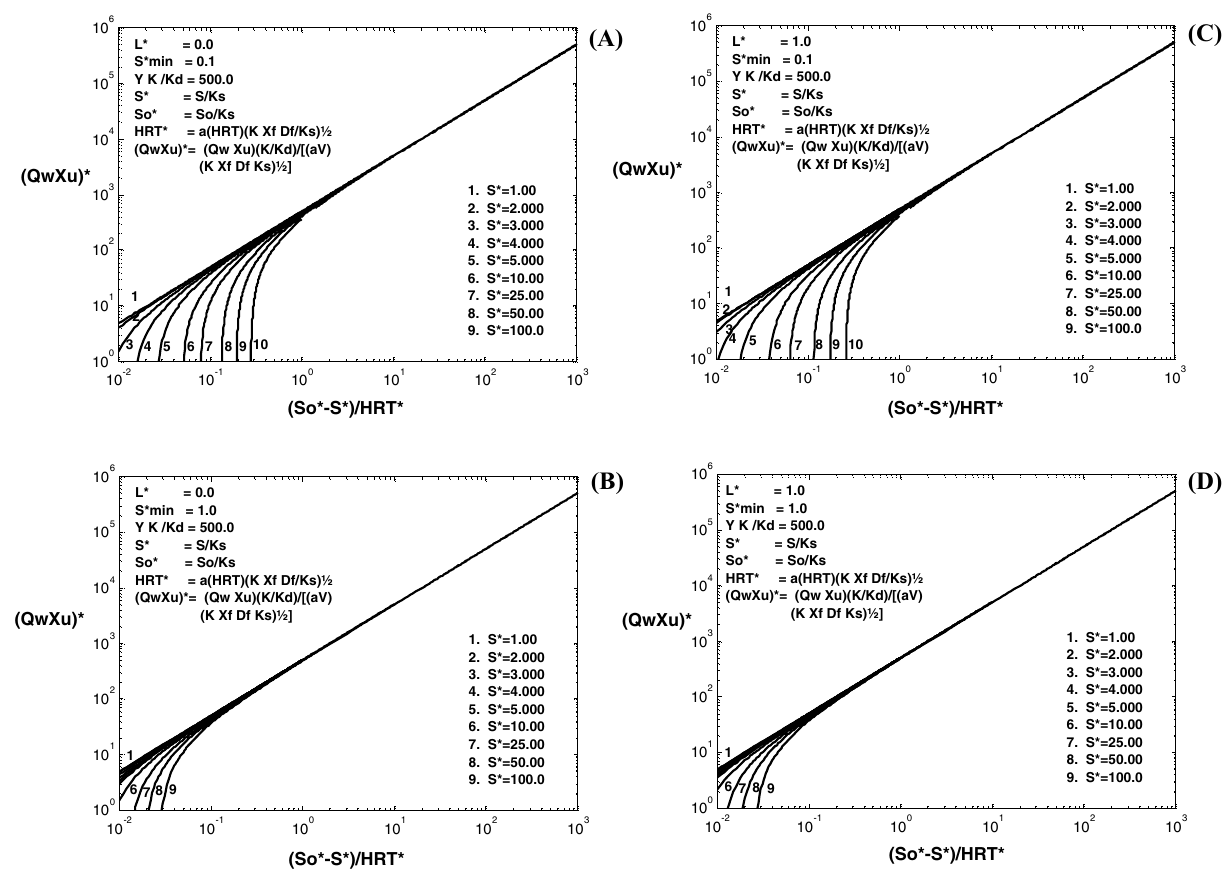
L * = 0.0, S ∗ min = 0.10, b L * = 0.0, S ∗ min = 1.0, c L * = 1.0, S ∗ min = 0.10 d d = 500.0, a